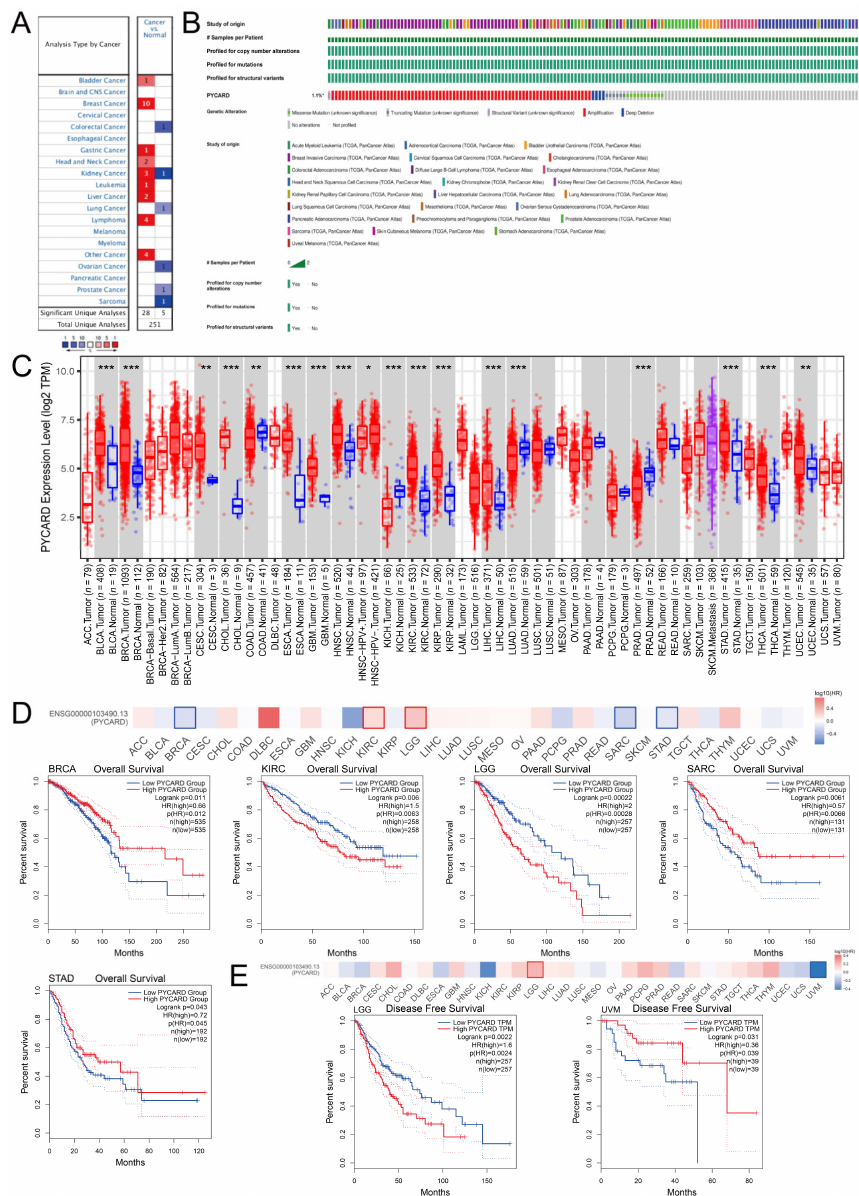
Figure 1. PYCARD expressions, genomic alterations and prognostic value in pan-cancer analysis. ( A ) PYCARD expression in pan-cancer analysis from Oncomine database. ( B ) The genomic alteration of PYCARD accounts for 1.1% of human cancers. ( C ) PYCARD expressions vary in different types of cancer. ( D ) Lower PYCARD expression is associated with worse OS in BRCA, SARC, STAD and higher PYCARD expression is associated with worse OS in KIRC and LGG ( p < 0.05). ( E ) Lower PYCARD expression is associated with worse DFS in UVM and higher PYCARD expression is associated with worse DFS in LGG ( p < 0.05). (* p < 0.05, ** p < 0.01, *** p < 0.001) (OS, overall survival; DFS, disease-free